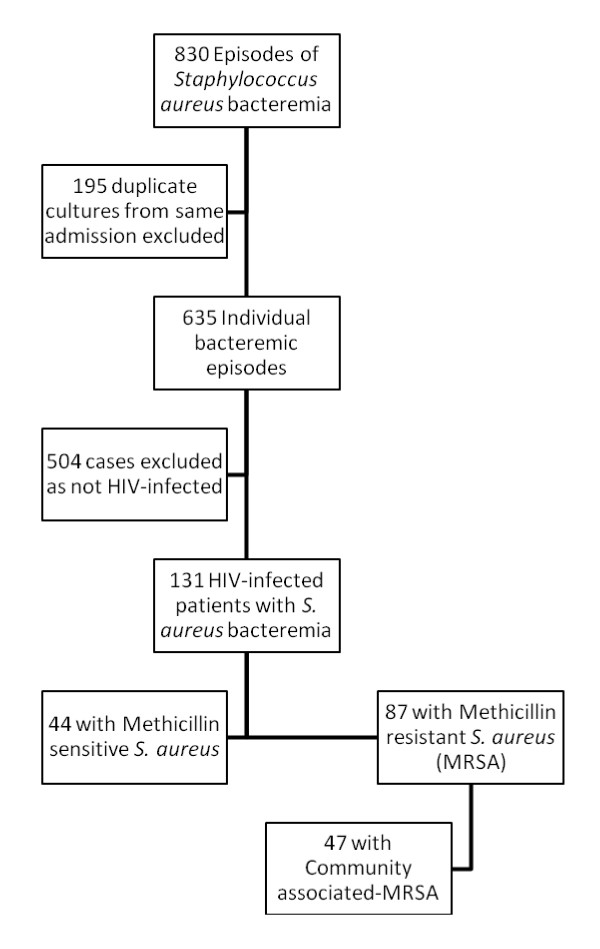
Selection of HIV-infected patients with methicillin resistant Staphylococcus aureus bacteremia flowsheet.